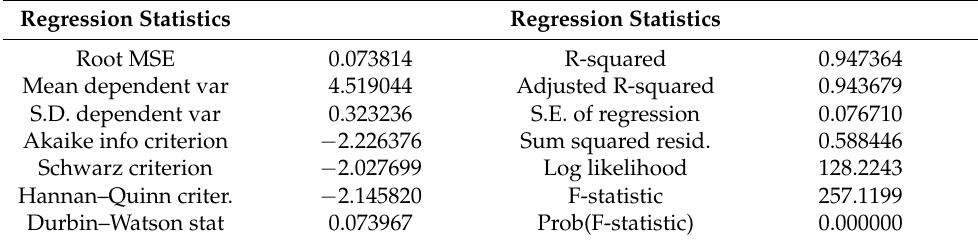
Table 8. The summary output of the regression model.